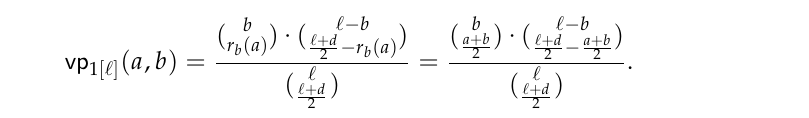
paths ( a , b ) in blue and # ↓